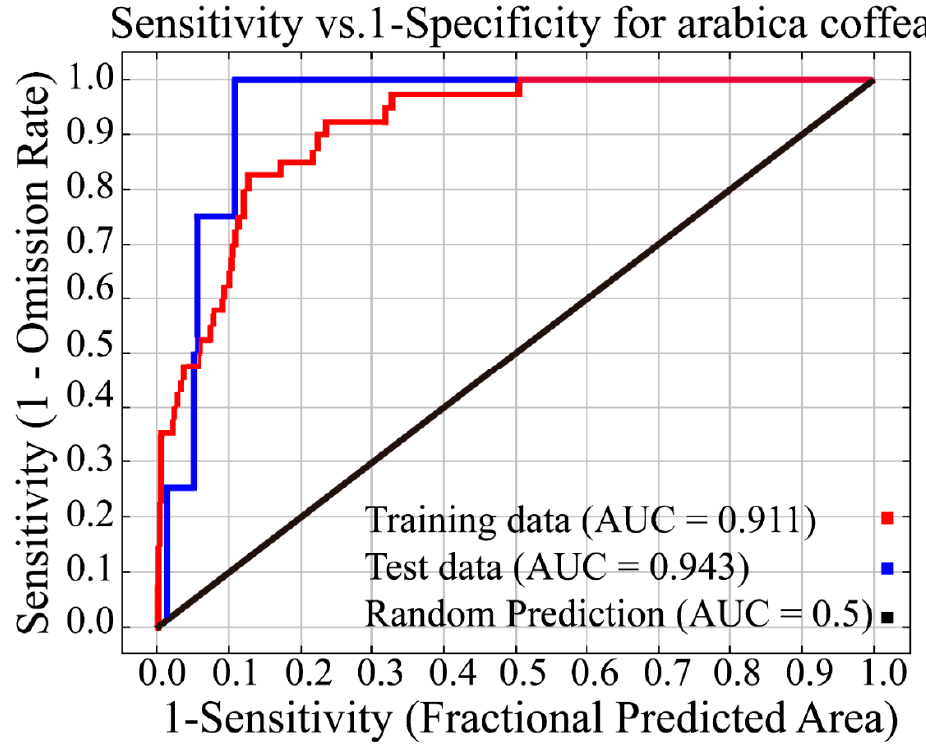
Figure 4. AUC accuracy model.